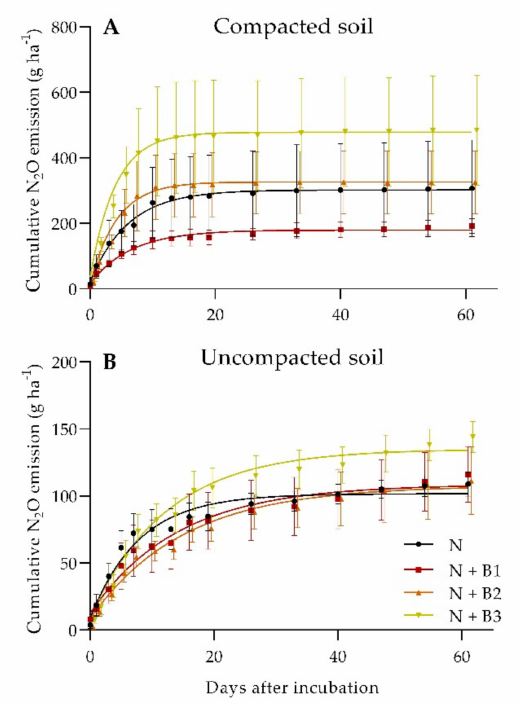
Figure 2. Timeline of cumulative N 2 O emissions from compacted ( A ) and uncompacted ( B ) Luvisol. Soil addition treatments: N—nitrogen fertilisation, B1—softwood from spruce (mixture of branches and wood chips) biochar, B2—digestate biochar, and B3—wood pallets from softwood (spruce without bark)